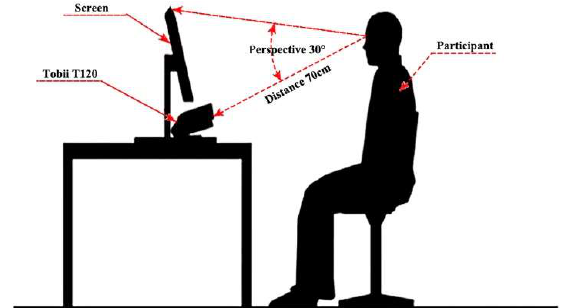
Figure 1. Schematic diagram.